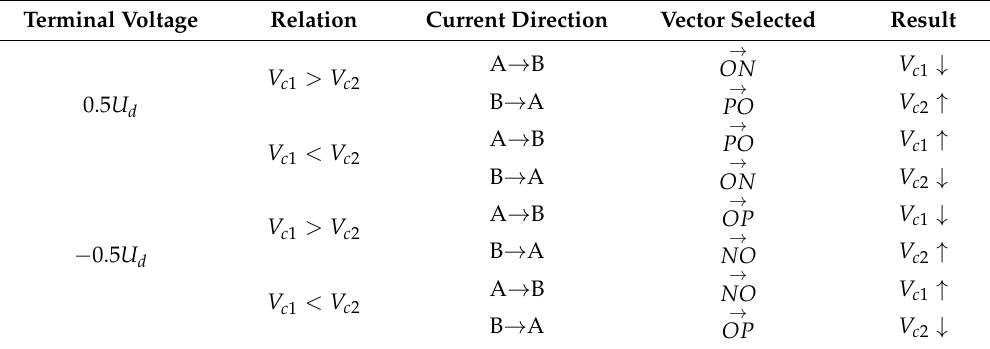
Table 2. Redundant vector selection.